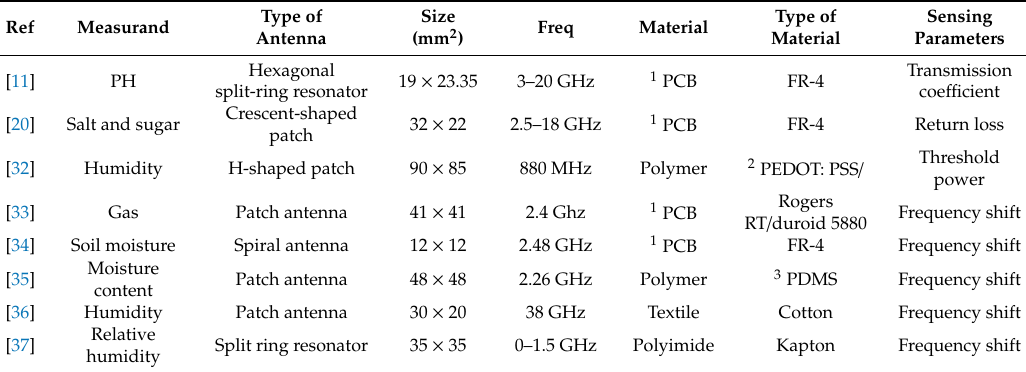
Figure 3. Configuration of an antenna dielectric sensor. Table 1. Summary of previously reported works on antenna dielectric sensors.